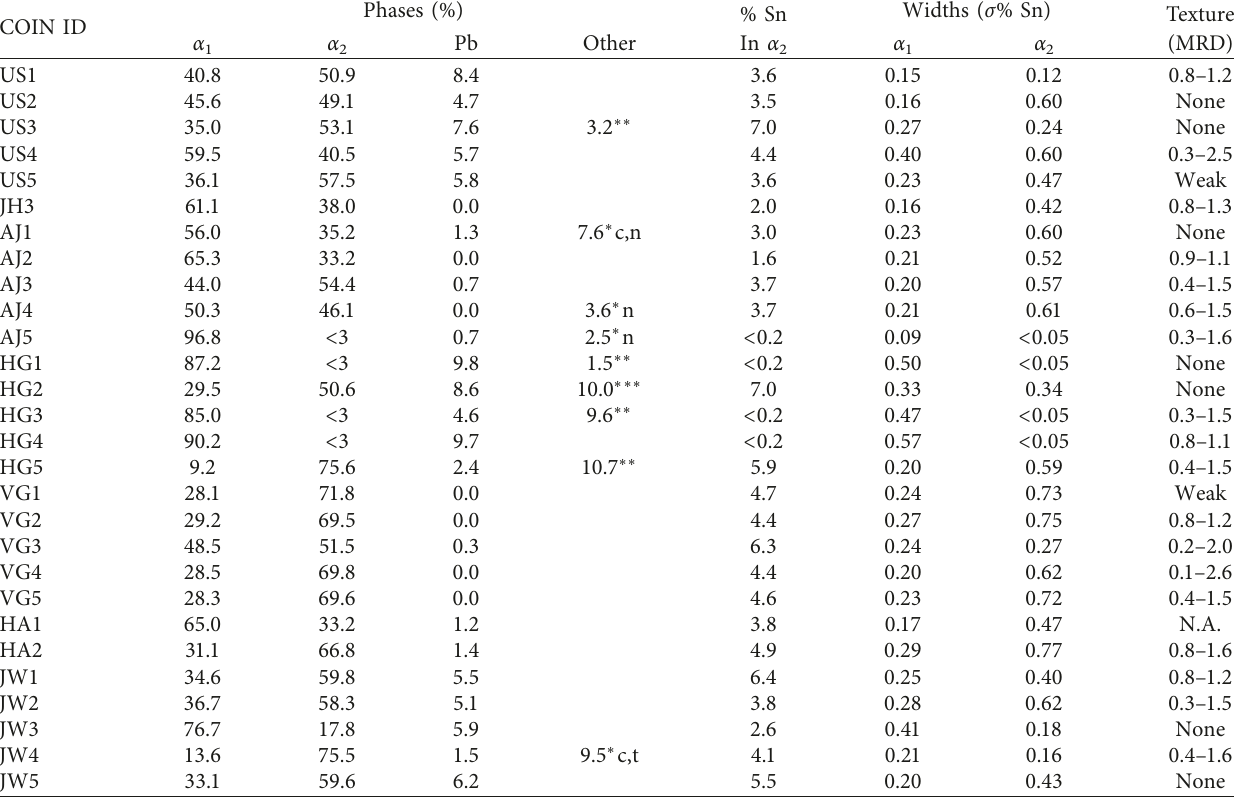
Table 1: TOF-ND fractions of each phase and their line